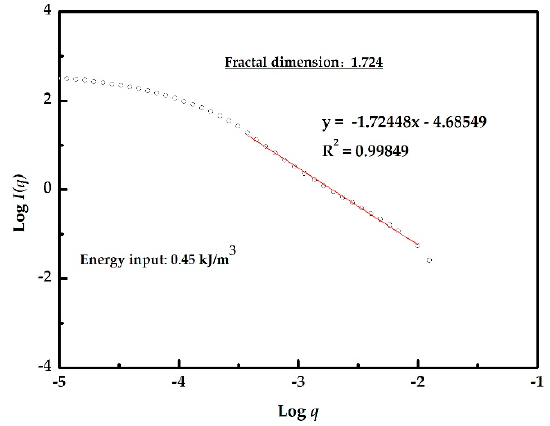
Figure 4. An example of the log-log plot for I ( q ) versus q.